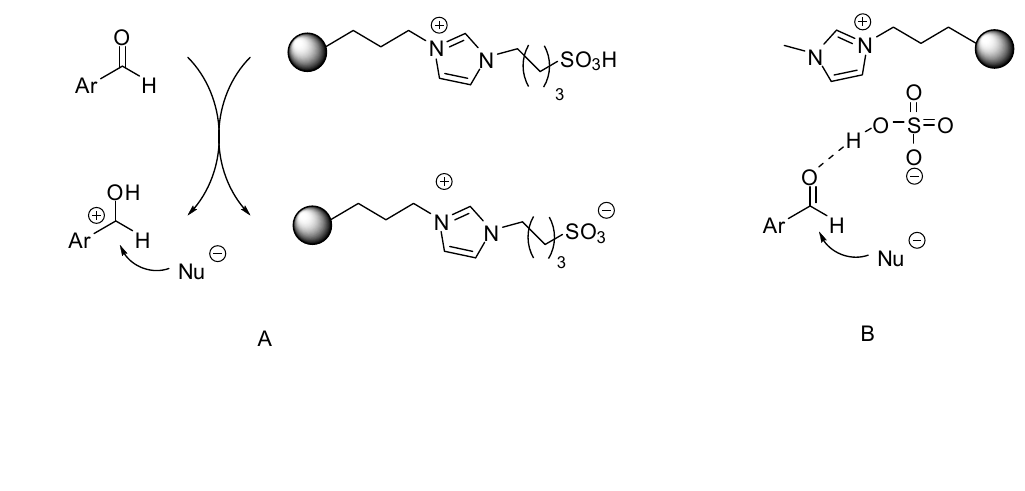
Figure 4. Activation of aldehydes via proton transfer from a SO ( A) [46], and via coordination of a HSO